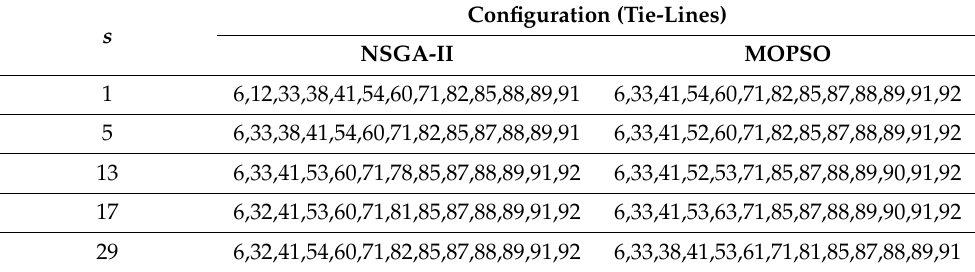
Table 11. The 83-node distribution network configurations at multiple scenarios.